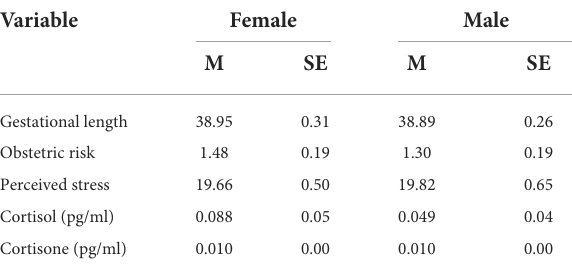
TABLE 5 Means of study variables for women who delivered female and male